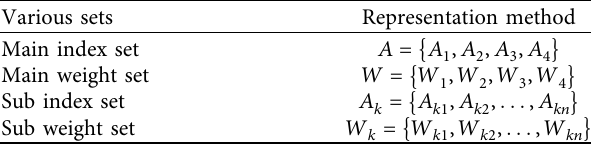
Table 2: Representation of factor set and weight set. Various